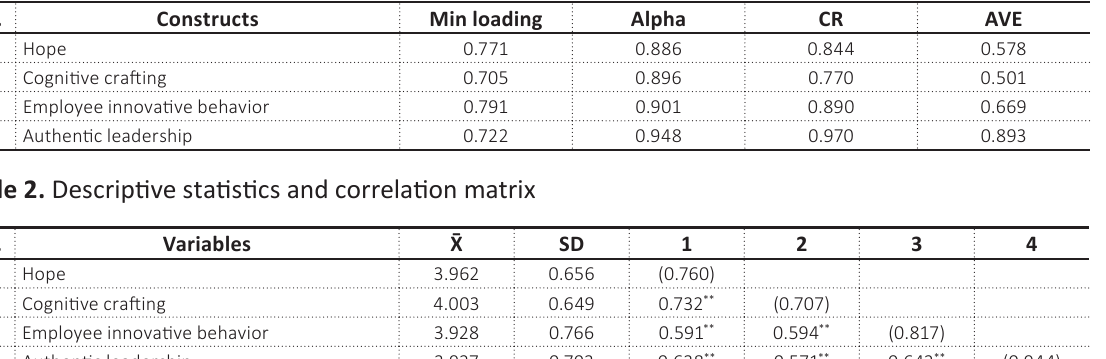
Table 1. Reliability and validity No.